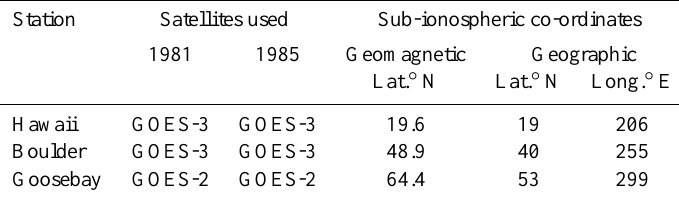
Table 1. Satellites used with their sub-ionospheric co-ordinates. Station Satellites used Sub-ionospheric co-ordinates 1981 1985 Geomagnetic Geographic Lat. ◦ N Lat. ◦ N Long. ◦ E Hawaii GOES-3 GOES-3 19.6 19 206 Boulder GOES-3 GOES-3 48.9 40 255 Goosebay GOES-2 GOES-2 64.4 53